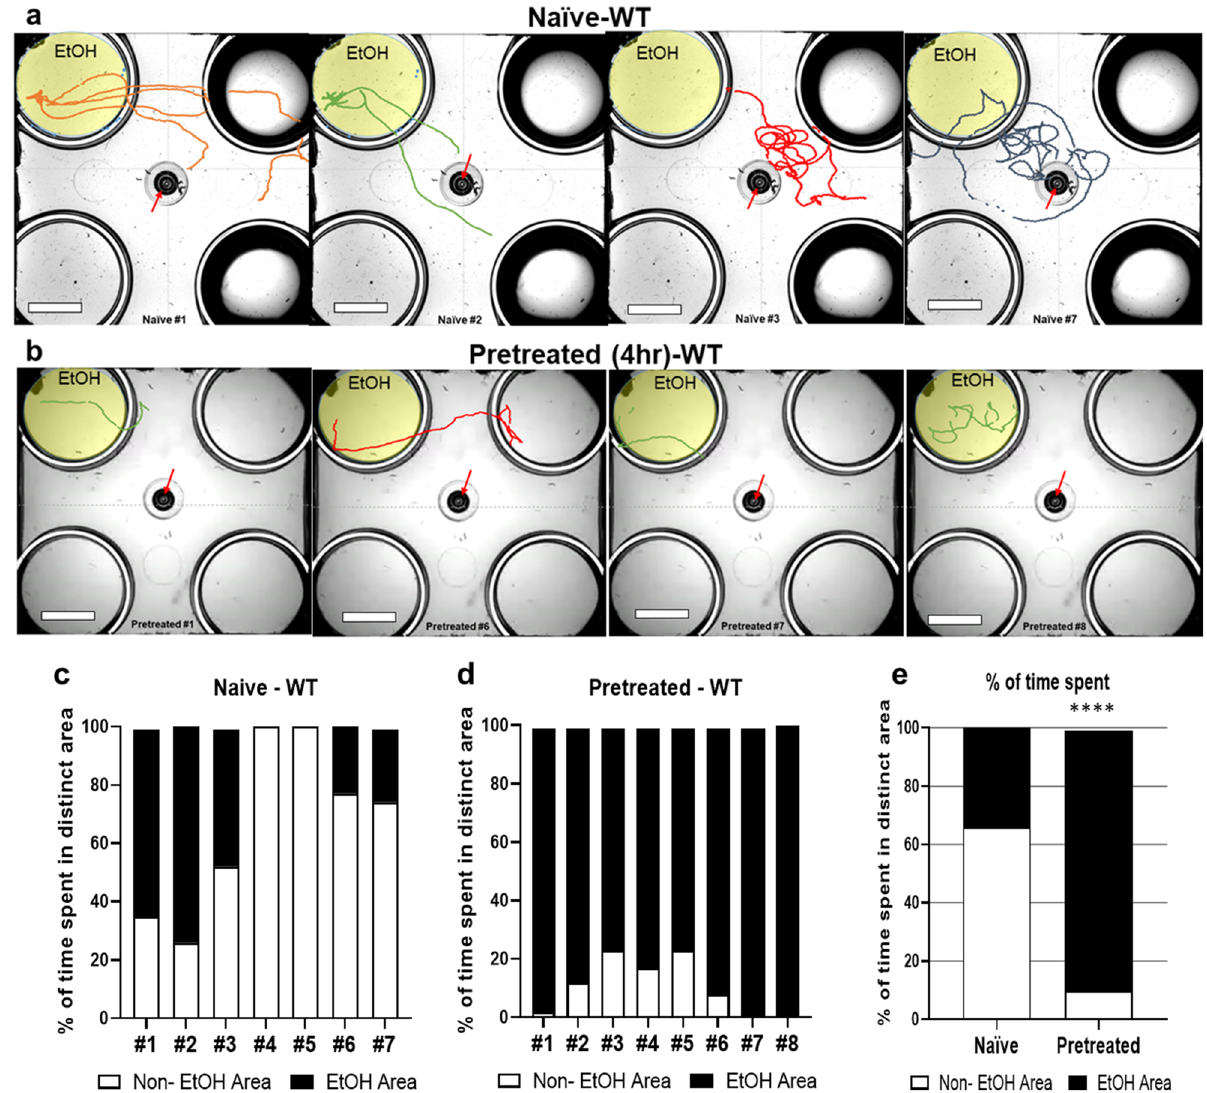
Figure 1. Ethanol-pretreated WT animals headed straight to the ethanol area and remained stayed. ( a , b ) Trajectory of individual WT animal (Naïve or Ethanol pretreated). The naïve ( a ) or ethanol pretreated animals ( b ), respectively, were placed in the middle of assay plate that contains ethanol (300 mM) only in the left top well. All wells are marginally covered by media that allows free moving between the area. Ethanol-pretreated WT animals (4 h; 300 mM) headed straight to ethanol area and stayed, whereas naïve wild type animals explored around. The arrow indicates initial points, where a worm was placed, and the trajectory represents the locomotion analysis for 30 min. During the short process of preparing for recording after placing, naïve animals explore near the initial point thus, the tracking path starts from the vicinity of the initial point, whereas the ethanol-treated animals have already moved toward the ethanol area consequently, the beginning of the tracking path is away from the initial point. Additional trajectories for individual animals were shown in Sup. 1. Scale bar = 10 mm. ( c , e ) Behavioral quantification of individual animal ( c ; Naïve, d ; 4 h-Ethanol pretreated) and average of total percentage time spent in the distinct area ( e ). The ethanol pretreated animals spent more time in ethanol area. The data were analyzed employing Chi-square test. chi-square test indicated; df 60.67, 1 z 7.789, **** p < to the ethanol area. The 23.08% of the trials in pretreated animals resulted in successful crossing to seek ethanol whereas only 3.45% of the trials in naïve animals. These repetitive attempting and crossing over the aversive bar- rier were hypothesized to be proportional to motivational compulsion to seek ethanol since ethanol pretreatment does not interfere with the ability of worms to detect Cu 2+ barrier. The sensitivity of ethanol-pretreated animals to aversive stimuli was not altered (Fig. 3b) consistent with previous findings that ethanol pretreatment did not affect attraction/aversion to volatile odorants 21 . Subsequently, we quantified the animals successfully reached to ethanol over aversive Cu 2+ barrier in time and Seeking Index (SI) was obtained as shown in (Fig. 3a). We tested what range of Cu 2+ concentration naïve or pretreated WT animals could cross over to reach the ethanol area. The drive of pretreated animals to seek ethanol superseded its aversive Cu 2+ response in a concentration-dependent